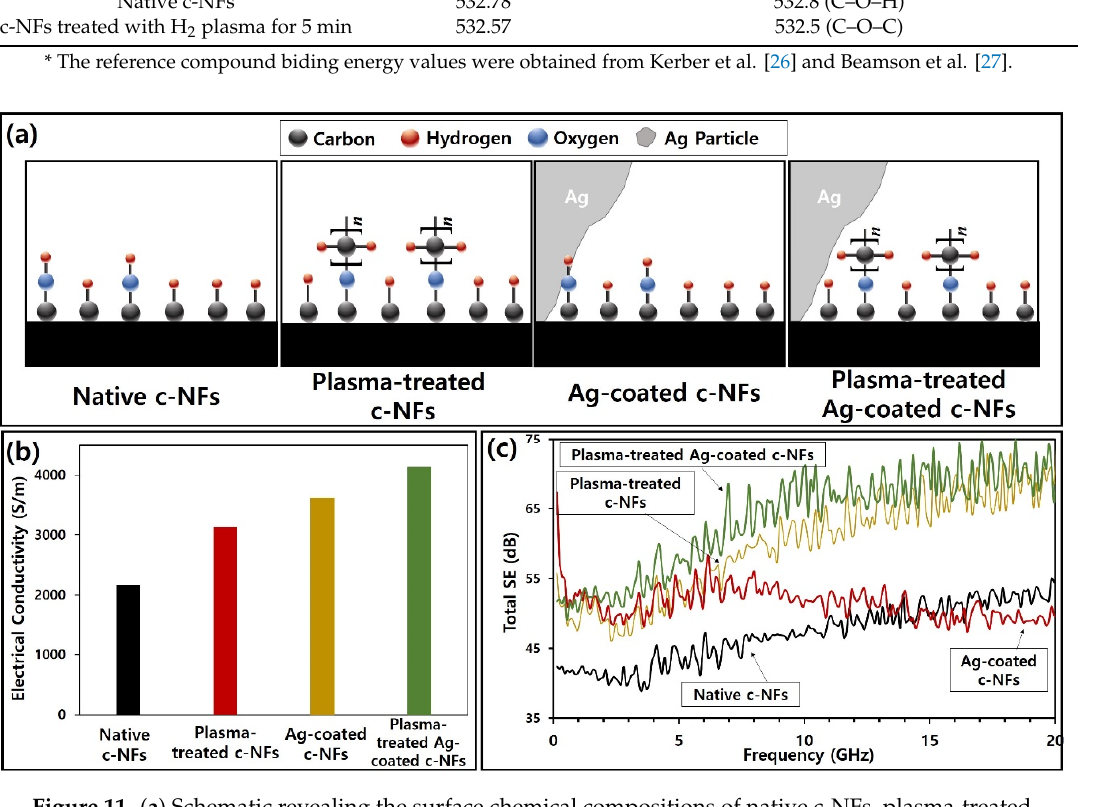
Figure 11. ( a ) Schematic revealing the surface chemical compositions of native c-NFs, plasma-treated c-NFs, Ag-coated c-NFs, and plasma-treated Ag-coated c-NFs; ( b ) bar graphs showing electrical conductivities of each sample; ( c ) variations in total SE as a function of operating frequency for